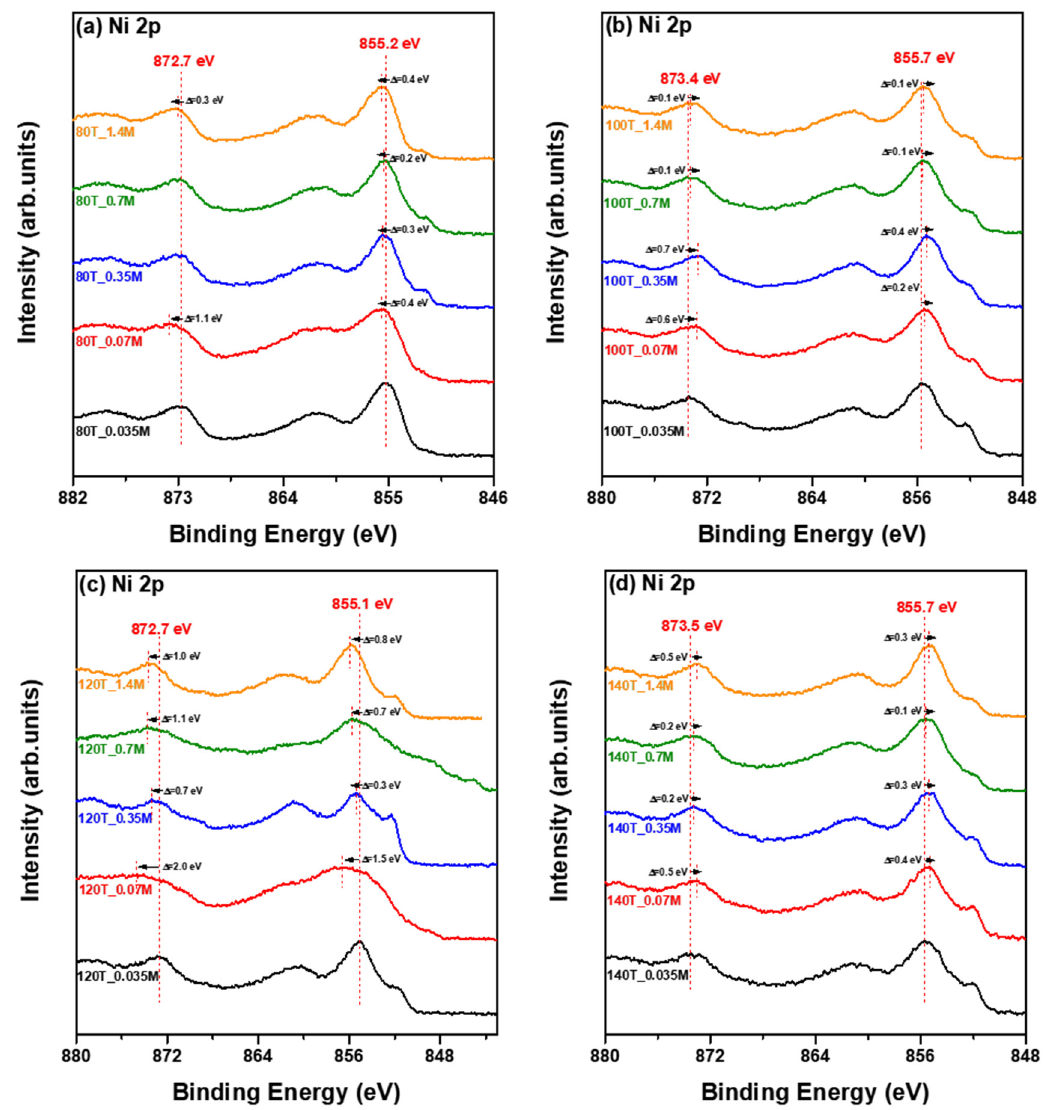
Figure 6. XPS Ni 2p spectra of Ni nanoparticles synthesized at 0.035 M, 0.07M, 0.35M, 0.7M, 1.4M of borane-ammonia complex concentration under ( a ) 80 °C, ( b ) 100 °C, ( c ) 120 °C, and ( d ) 140 °C, re- spectively.